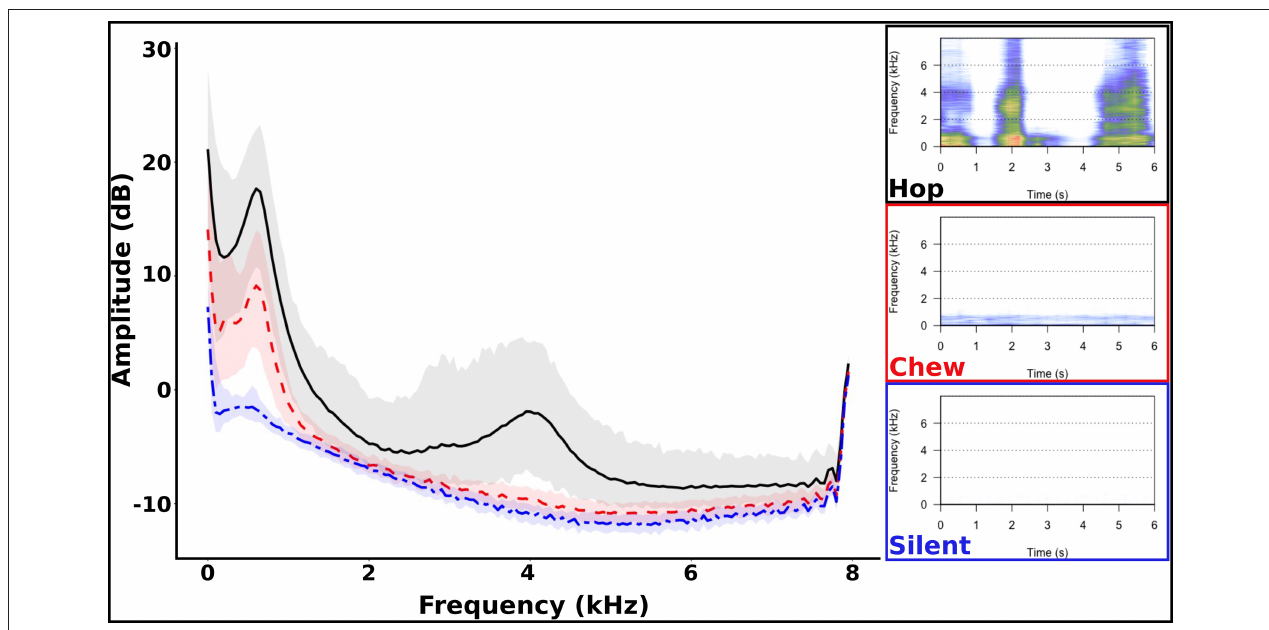
FIGURE 4 | Amplitude frequency spectral properties of hop, chew, and silent sounds from animal-borne acoustic recorders on snowshoe hares (Right) and accompanying spectrograms (Left) . Shading represents the 95% CI of the amplitude for each behavior.